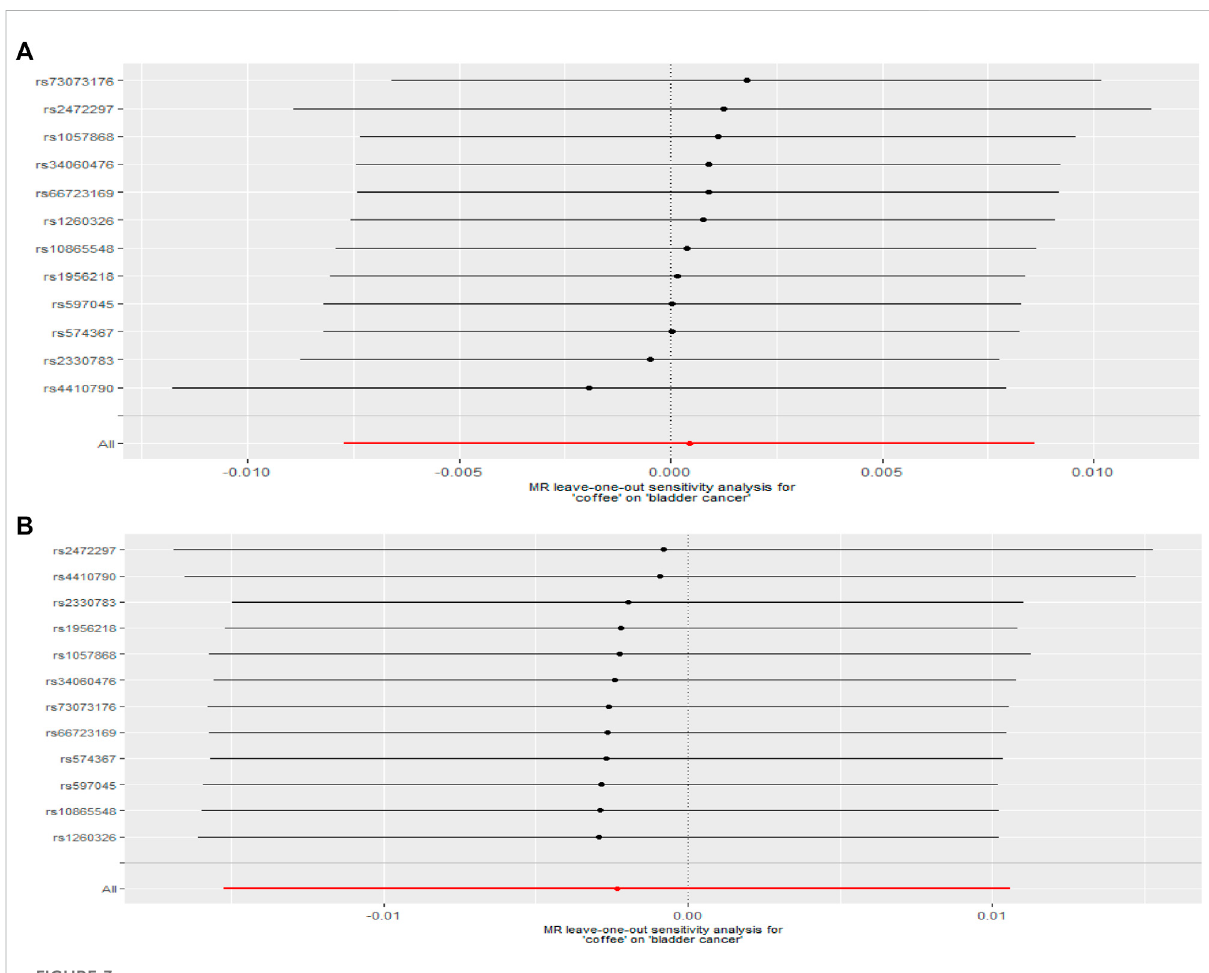
FIGURE 3 Leave-one-out analysis. (A) United Kingdom Biobank (A) and (B) FinnGen